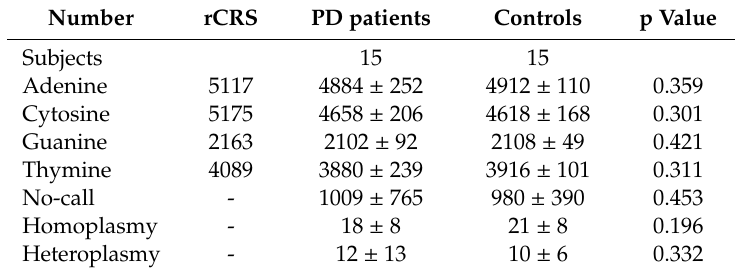
Figure 1. Chaos Game Representation (CGR) of human mtDNA. ( a ) CGR matrices for L = 1 to L = 6 of whole revised Cambridge Reference Sequence, rCRS, display self-similarity, a property peculiar to fractals, resembling ( b ) the triangle of Sierpinski, an ideal fractal built through repeated iterations starting from a square. Table 2. Characteristics of mtDNA sequences processed by the proposed